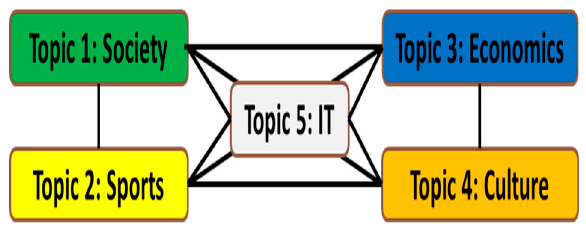
Figure 33. Overview of the high and low modularity in a graph (Ref. [128]).